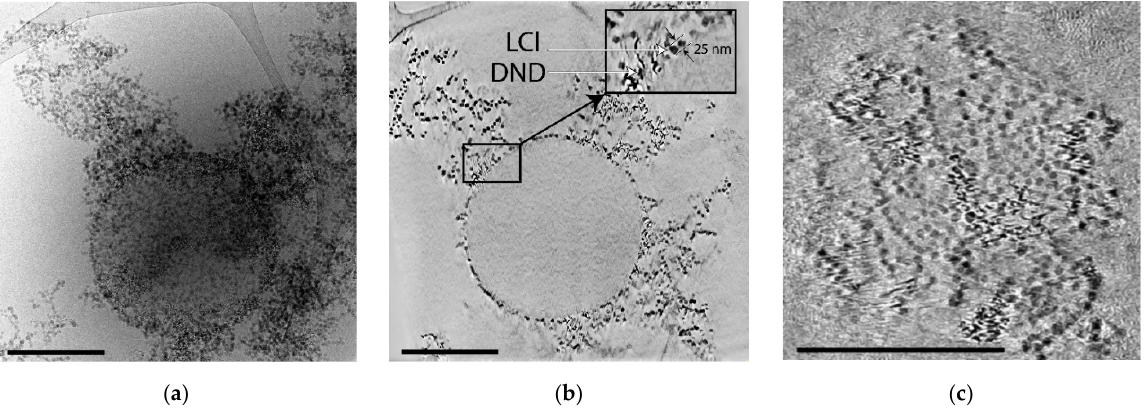
Figure 9. Cryo-TEM image ( a ) and tomographic slices ( b , c ) of (LCl + DND)/LCl/alginate/chitosan microcapsule; ( b ) slice through the center of the microcapsule; ( c ) slice through the upper boundary. Scale bar is 400 nm.